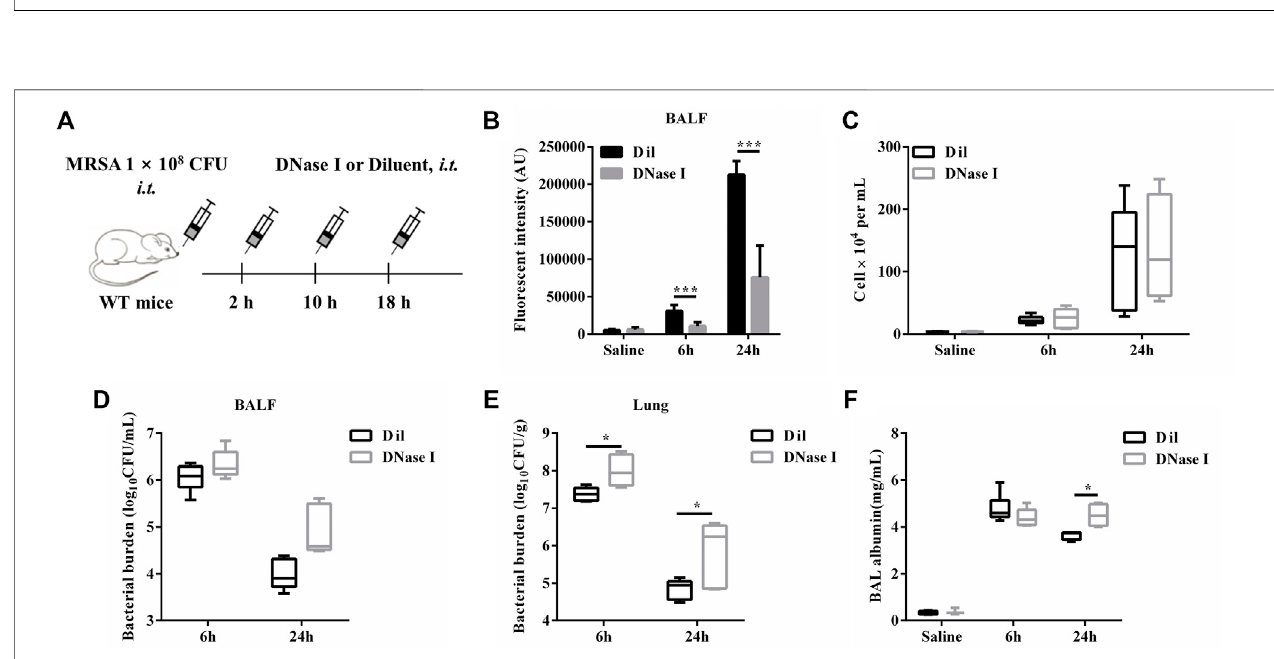
FIGURE 6 | ETs degradation with DNase I is detrimental during S. aureus pulmonary infection. WT mice were challenged with S. aureus (1 × 10 8 CFU/mouse, i. t. ) and treated with DNase I (4000 U, i. t. ) or diluent control at 2, 10, and 18 hpi (n = 4 – 6/group) and then were euthanized at 6 and 24 hpi. (A) A schema of the experiment timeline. (B) cfDNAinBALF, (C) BALFWBC, (D) bacterialcountsinBALF, (E) bacterialcounts inlungs, and (F) BALFalbumin concentrationwerequanti fi ed.Alldataare shownasmean±SEM.Datapooledfrom2independentexperiments.Datawereanalyzedusingtwo-wayANOVAwithBonferroni ’ smultiplecomparisontest,* p < 0.05, *** p <